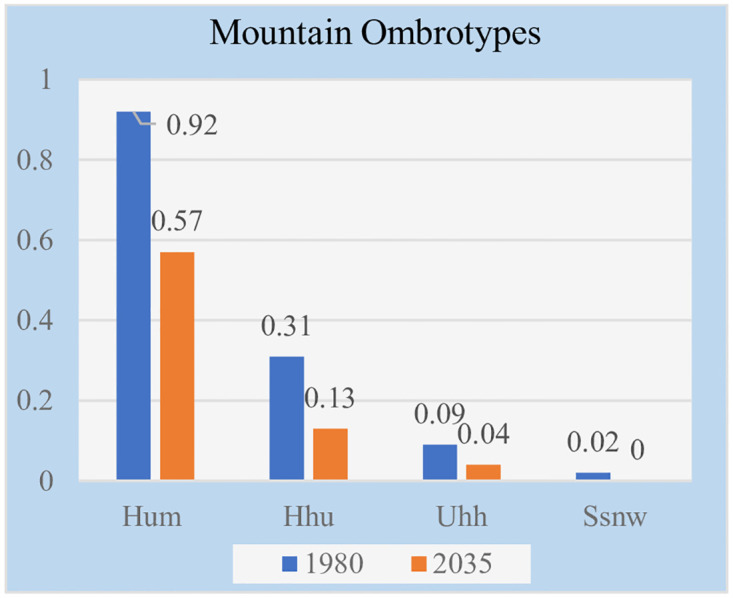
Mountain ombrotypes.